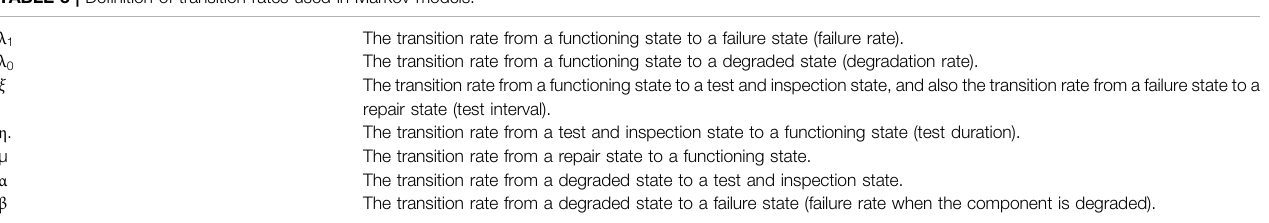
TABLE 3 | De fi nition of transition rates used in Markov models. λ 1 The transition rate from a functioning state to a failure state (failure rate). λ 0 The transition rate from a functioning state to a degraded state (degradation rate). ξ The transition rate from a functioning state to a test and inspection state, and also the transition rate from a failure state to a repair state (test interval). η .